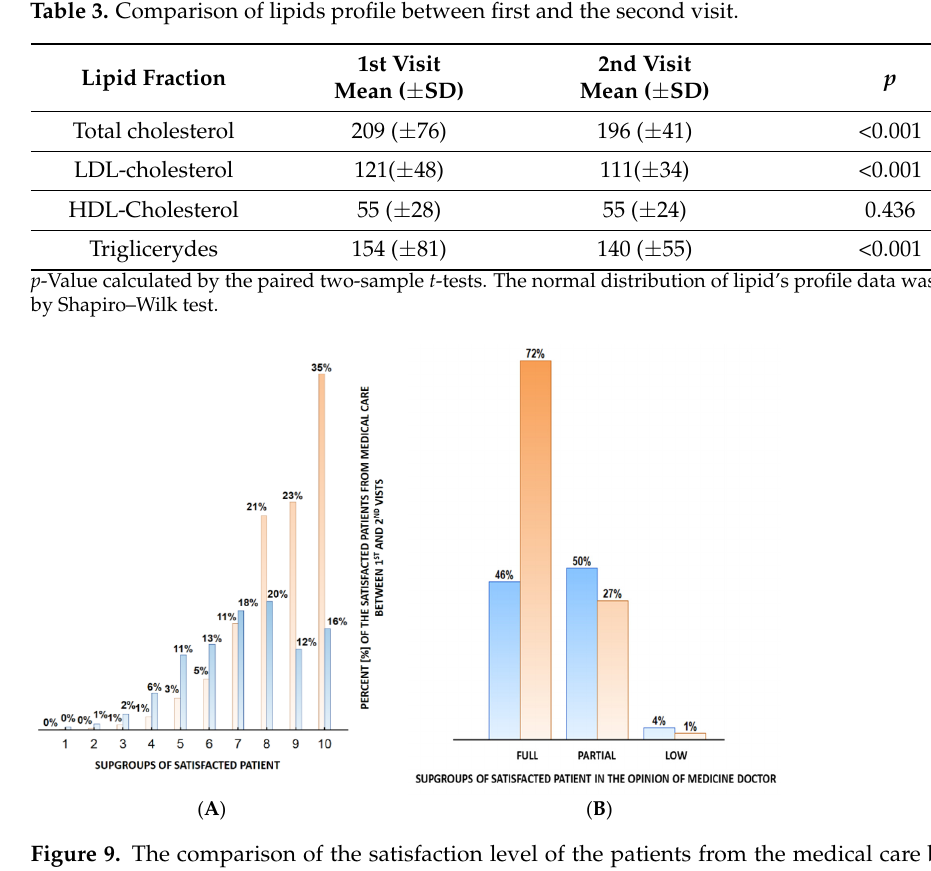
Figure 10. Subjective assessment of satisfaction with the treatment—completion of pharmacother- apy targets in the opinion of the doctor ( p < 0.001). 5. Factors Influencing Medical Adherence to Lifestyle Modification In general, the inhabitants of small towns (50–100,000 inhabitants) follow the recom- mendations the best (over 85% vs. 80% in villages and larger towns; p = 0.01), and the worst was in patients aged 70–90 years (75% vs. 85% in younger age groups; p = 0.00001) as well as old age and retired (79% vs. 85% compared to the employed; p = 0.0002). The gender and type of work performed did not have statistical significance.